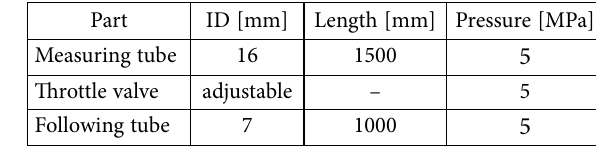
Table 1. Size of system